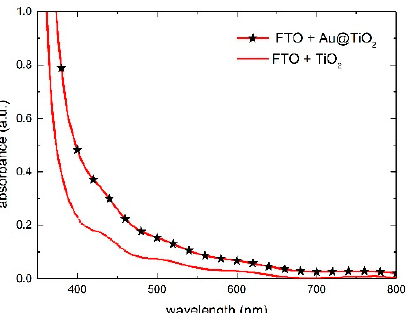
Figure 5. Absorbance spectra of the reference TiO 2 and the one mixed with Au@TiO 2 .